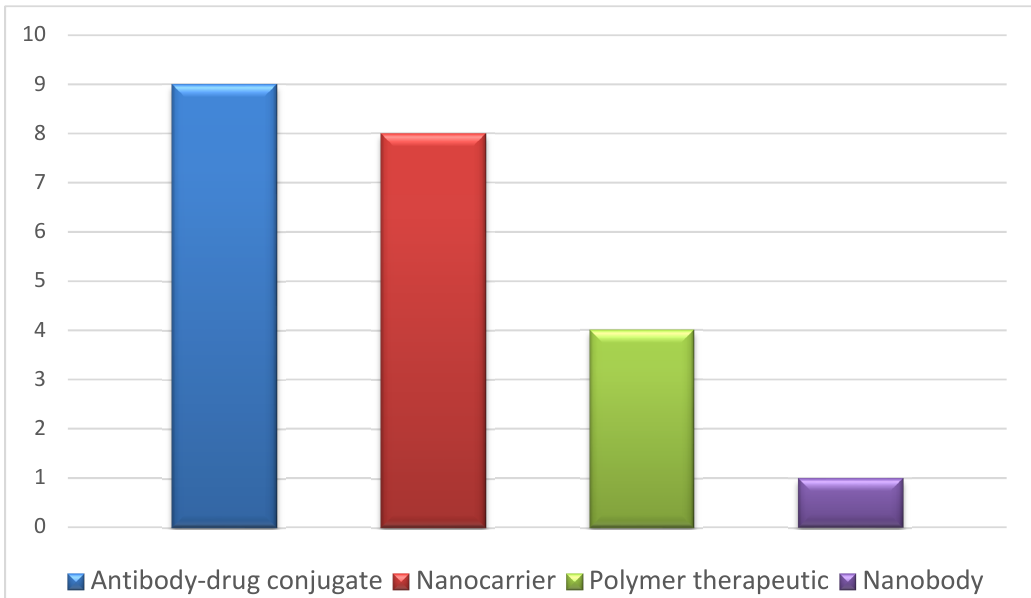
Figure 3. Categories of nanomedicines identified in the IMPDs and number of instances. Depending on their characterization or control strategy, analytical methods such as electrospray ionization mass spectrometry, matrix-assisted laser desorption ionization time-of-flight, size exclusion high-performance liquid chromatography and sodium do-